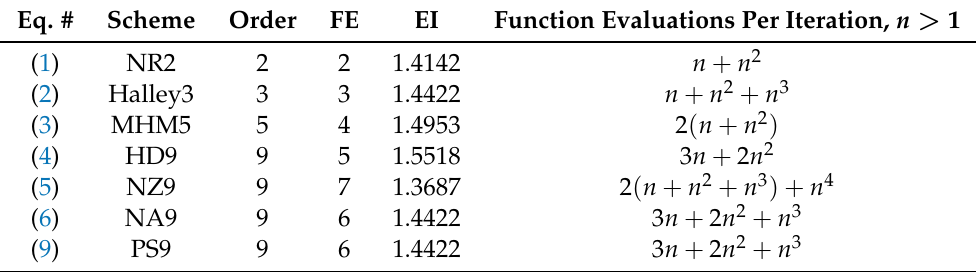
Table 1. Theoretical comparison of schemes under